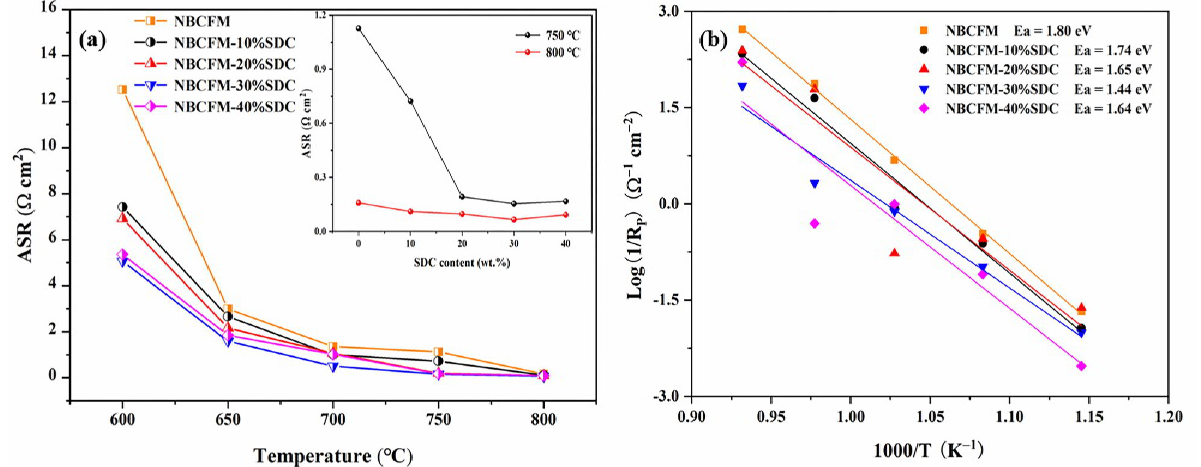
Figure 7. ( a ) ASR values for NBCFM- x SDC composite cathodes at 600–800 ◦ C in air; inset shows de- pendence of ASR for NBCFM- x SDC composite cathodes with different SDC contents at 750 ◦ C and 800 ◦ C; ( b ) Arrhenius plots of the polarization resistance of the NBCFM- x SDC composite cathode materials.